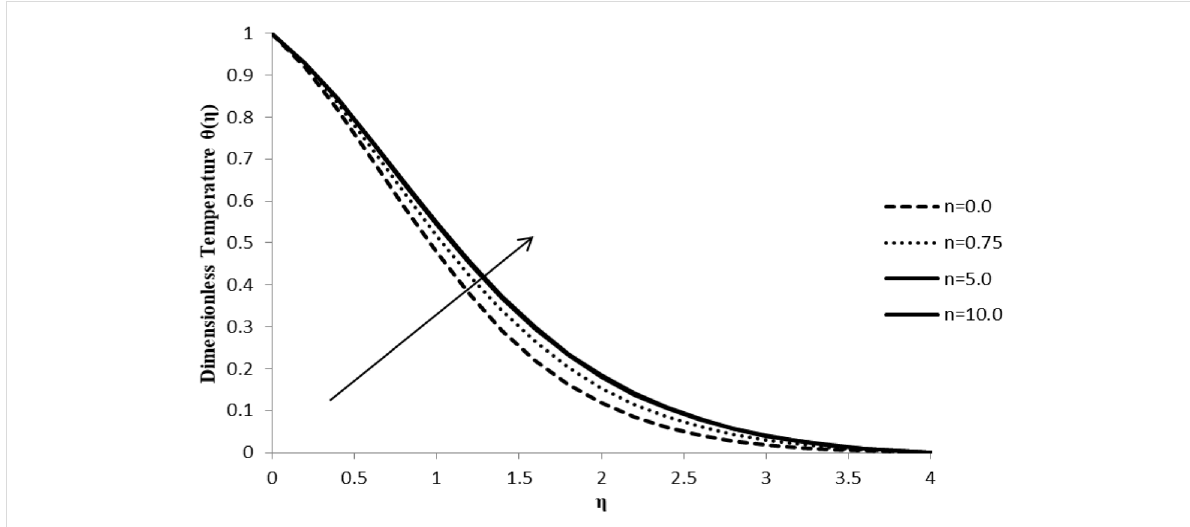
Figure 6: Influence of the stretching parameter n on the temperature distribution θ ( η ) when ξ = 1.0, M = Q = 0.0, Pr = 2.0, Nb = Nt = 0.5, Le = 5.0, and F w = 0.2 (due to the boundary condition, the value of ξ is changed).